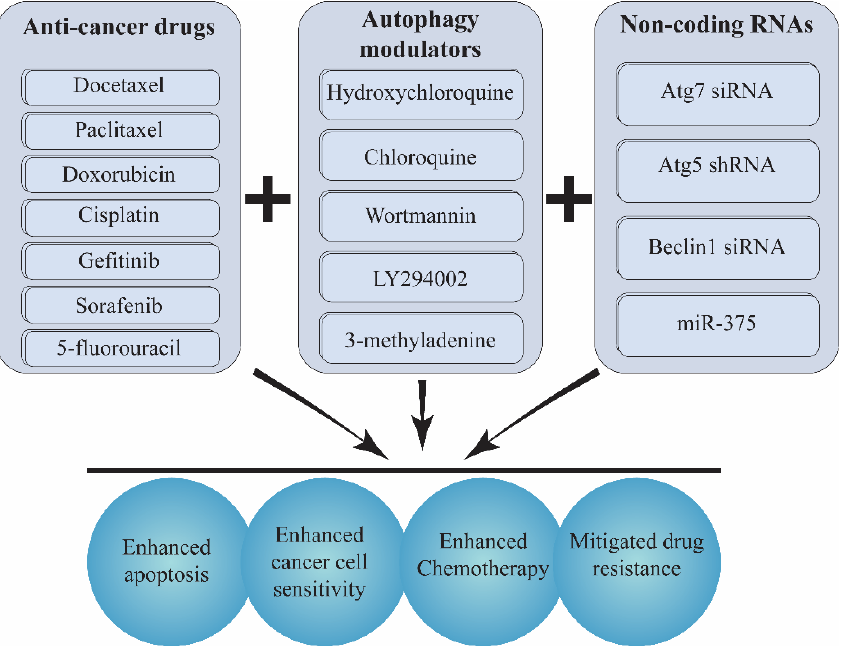
Figure 4. A combination of chemotherapeutic agents with autophagy genes modulators or autophagy regulators enhances the potential of